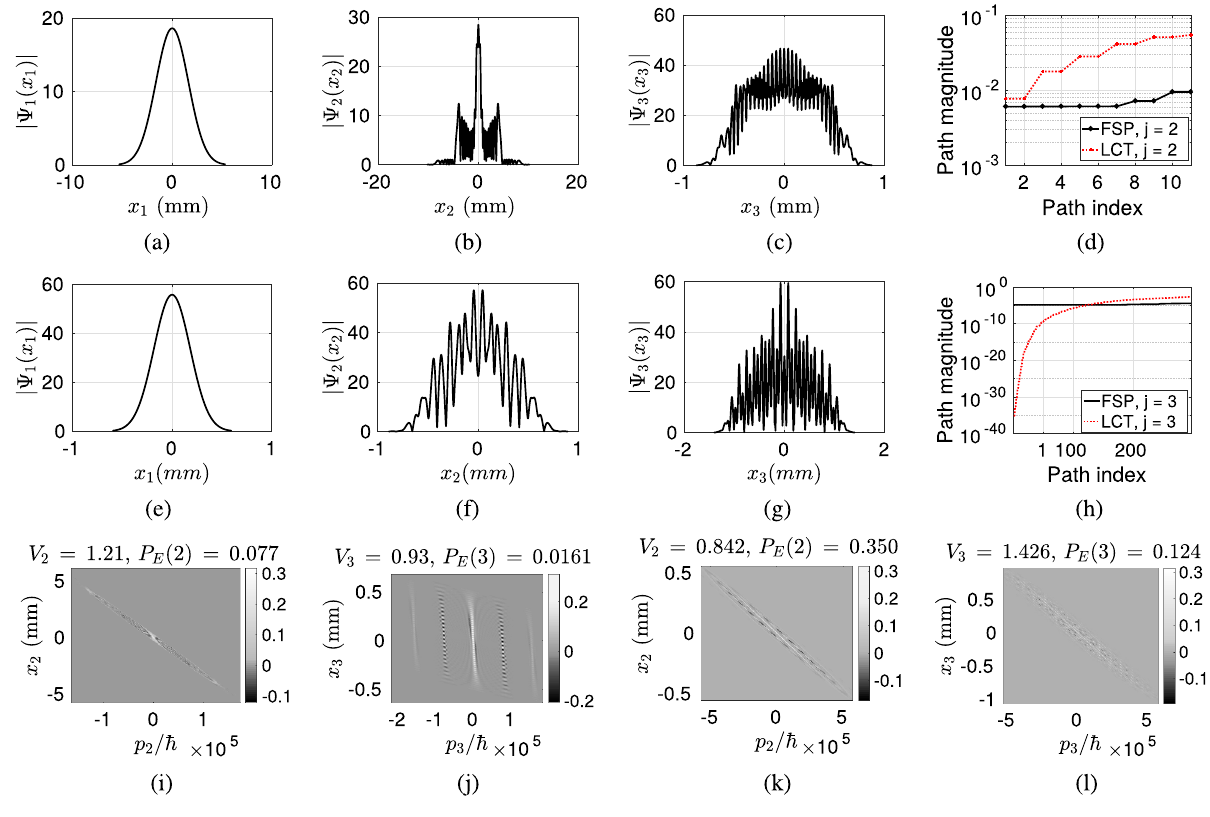
20 µ m is utilized where the resulting spatial domain waveforms on the Figure 10. Gaussian source with σ 0 = 1 , ( b ) j 2 and ( c ) j 3 for FSP, and ( e ) j 1 , ( f ) j 2 and ( g ) j 3 for LCT. planes with the indices ( a ) j = = = = = = 2 and ( h ) j 3 . Scaled Wigner distribution (cid:31) P E ( n , j ) for ( d ) j W j ( x j , p j ) for FSP on the planes with ( i ) = = × 2 and ( j ) j 3 , and for LCT with ( k ) j 2 and ( l ) j 3 j = = = =